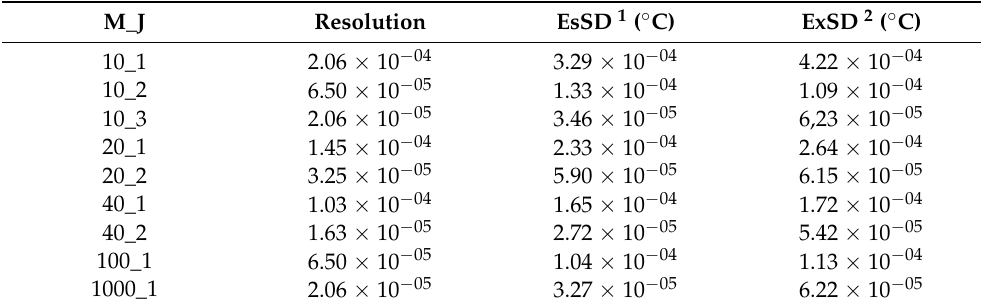
Table 2. Mean and Variance of the average temperatures.